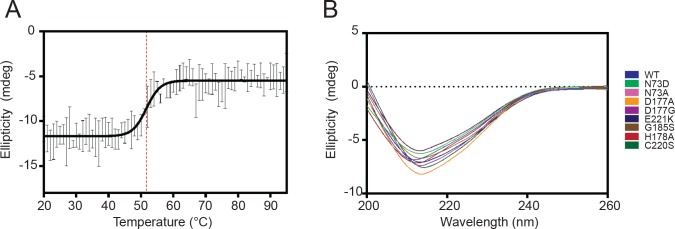
Circular dichroism analysis of HaAEP1 secondary structure.(A) Melt curve of pro-AEP (pH 8) HaAEP1 measured at 222 nm, [0.2 mg/mL], shows a melting temperature of ~52°C. n = 3 technical replicates data fitted with sigmoidal four parameter logistic regression fit. (B) Circular dichroism spectroscopy of pro-AEP (pH 8) WT HaAEP1 and active site mutants, [0.1 mg/mL], average of n = 2 technical replicates.